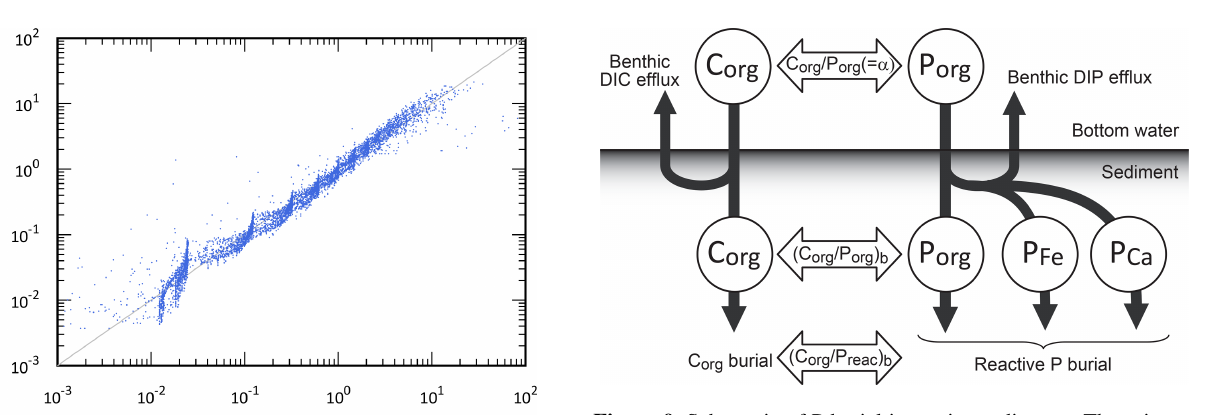
Figure 9. Schematic of P burial in marine sediments. The primary source of P to the sediment is the deposition of organic matter, which represents the C : P ratio of primary producers, α . Phospho- rus deposited in sediments is a subject of decomposition and sink switching. Most of the deposited organic P is decomposed before burial and the DIP released to pore waters diffuses to the bottom water. A fraction of the liberated P is trapped by iron hydroxides or buried as authigenic minerals (e.g., carbonate fluorapatite). Three reactive phases, organic P (P org ), Fe-bound P (P Fe ), and Ca-bound P (P Ca ), are considered in the CANOPS-GRB model. The burial of these species are redox dependent: burial efficiency is affected by bottom water O 2 concentration. Because of the sink switching, sed- imentary C org / P reac , rather than C org / P org ratios, provides a correct measure of the retention vs. diffusive loss of remineralized